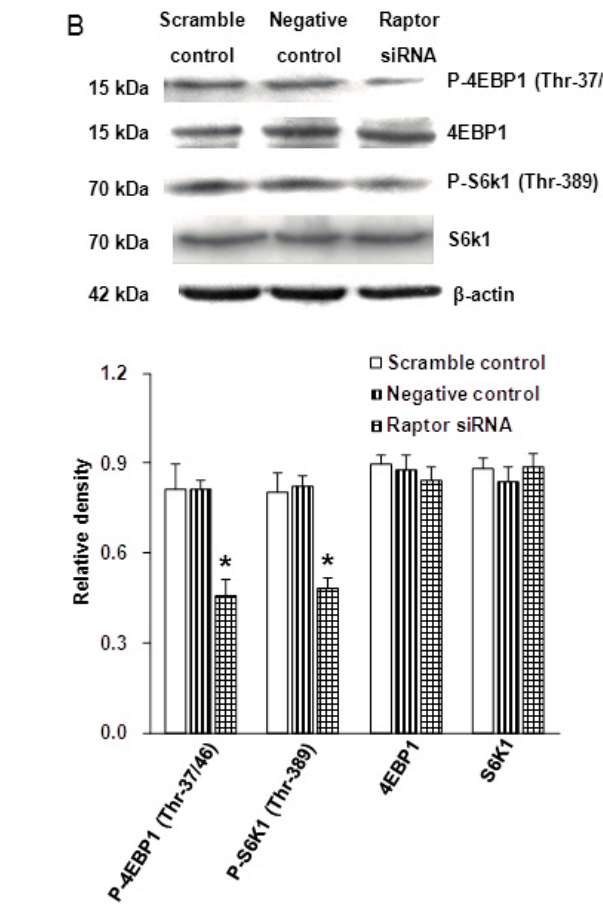
Figure 1. Effect of rapamycin and raptor silencing on mTORC1 activity. ( A ) Representative western blot analysis of phosphorylated S6k1 (Thr-389) and phosphorylated 4EBP1 (Thr-37/46) expression in the cell lysates of 100 nM rapamycin treated and control cells. Rapamycin significantly reduced the expression of phosphorylated S6k1 (Thr-389) and phosphorylated 4EBP1 (Thr-37/46), whereas it had no effect on total S6K1 and total 4EBP1 expression. Values are present as mean ± SD. n = 4, * p < 0.05 versus ( vs. ) control by Mann–Whitney U- test; ( B ) Representative western blot analysis of phosphorylated S6k1 (Thr-389) and phosphorylated 4EBP1 (Thr-37/46) expression in the cell lysates of the scramble control, negative control and raptor silenced cells. Phosphorylation of S6k1 (Thr-389) and 4EBP1 (Thr-37/46) was significantly decreased in the raptor silenced cells, but total S6K1 and total 4EBP1 expression were not changed. Values are present as mean ± SD. n = 4, * p < 0.05 vs. scramble control and negative control by Kruskal-Wallis test followed by Mann-Whitney U